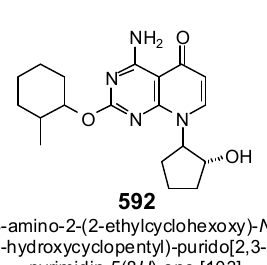
Figure 30. Structures of the synthetic NAD + ‐ dependent DNA ligase inhibitors.